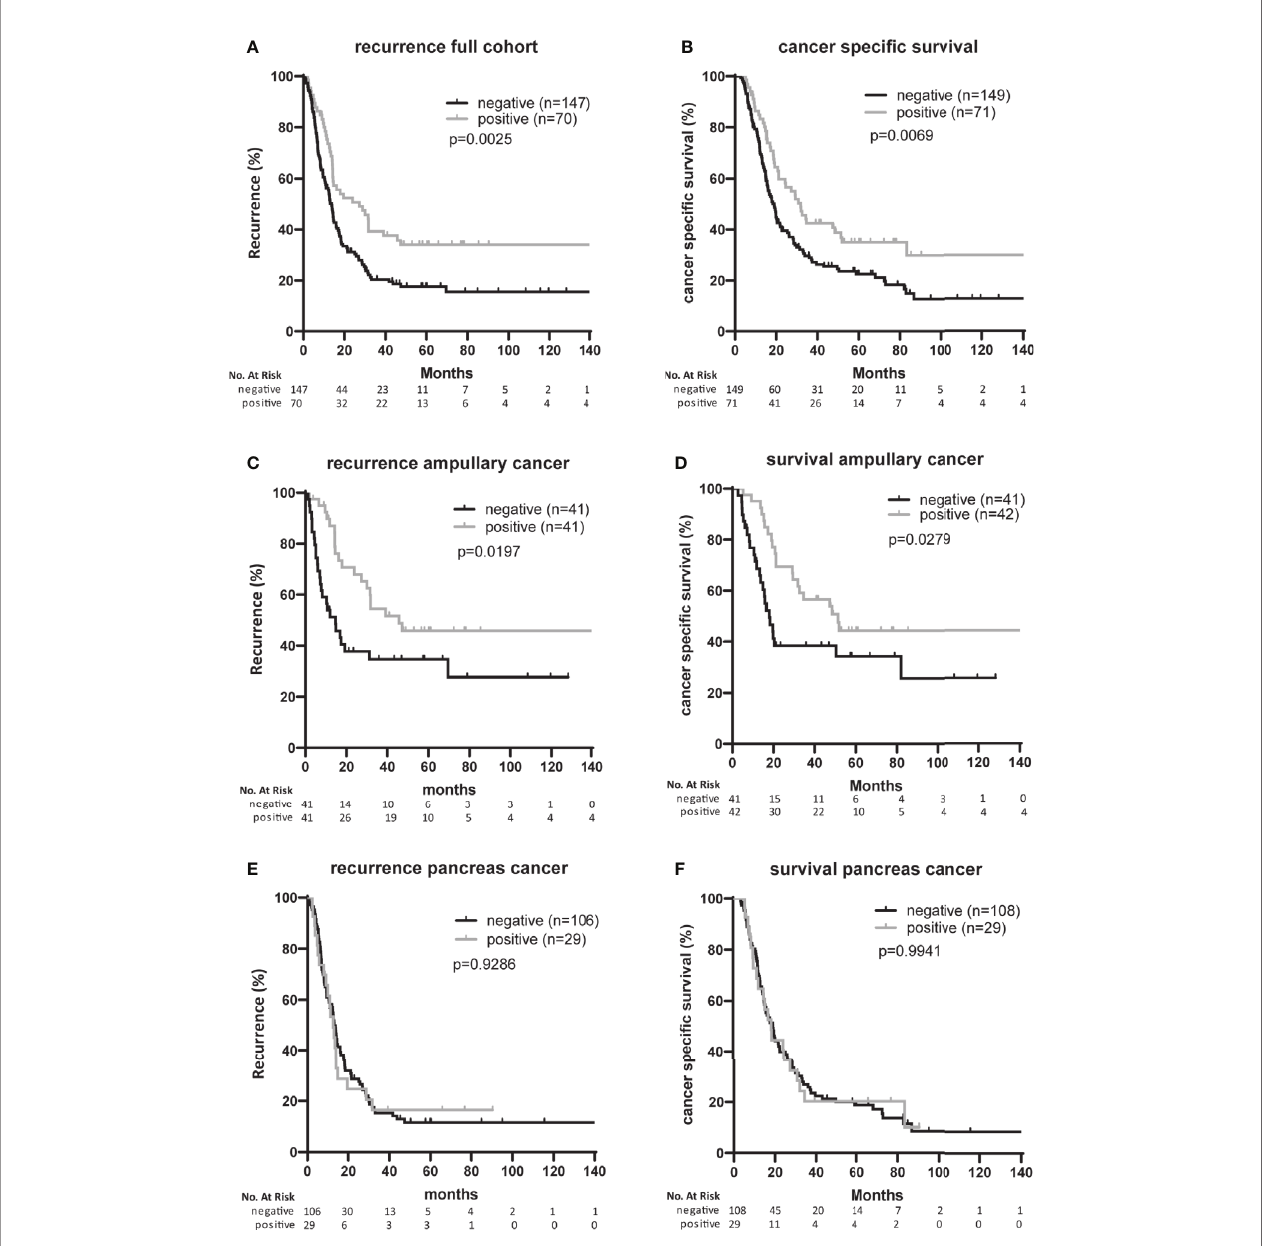
FIGURE 2 | Associations of B7-H3 expression on cancer cells with patient survival and tumor recurrence (A, B) . Full cohort. Kaplan Meier plots showing recurrence- free survival time (A) and cancer-speci fi c patient survival (B) after resection of tumors with or without B7-H3 expression in cancer cells. (C, D) Ampullary cancer patients. Kaplan Meier plots showing recurrence-free survival time (C) and cancer-speci fi c patient survival (D) of patients after resection of tumors with or without B7- H3 expression in cancer cells. (E, F) Pancreatic cancer patients. Kaplan Meier plots showing recurrence-free survival time (E) and cancer-speci fi c patient survival (F) of patients after resection of tumors with or without B7-H3 expression in cancer